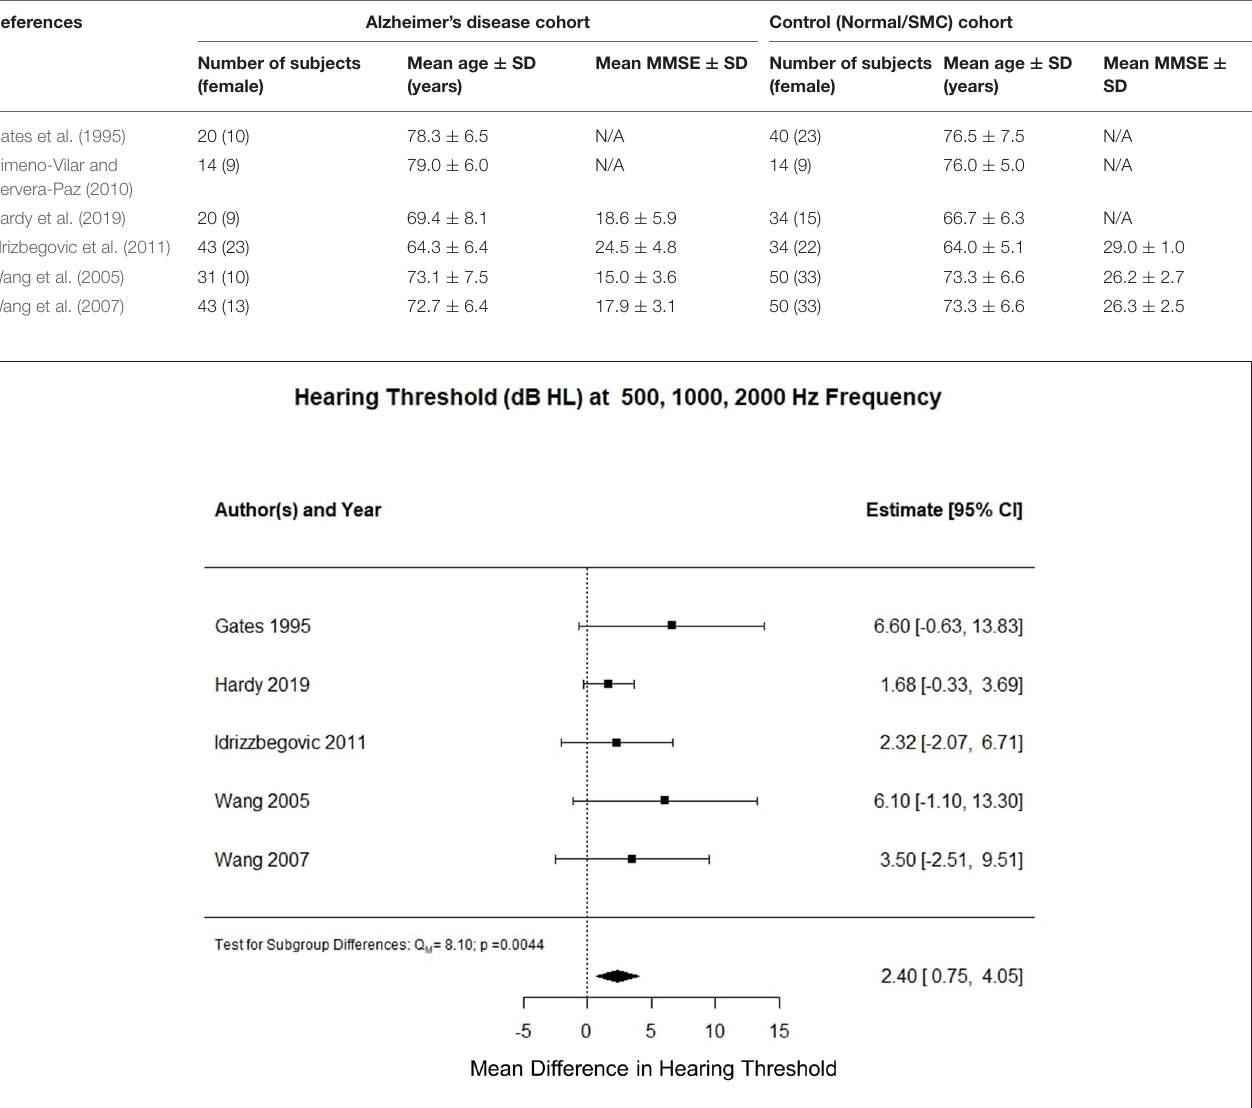
featured an individual positive correlation between hearing loss and AD, which combined provided a pooled positive